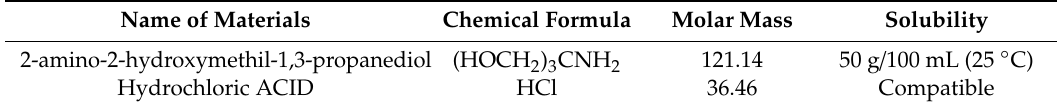
Table 2. Specifications of alkaline (Tris) bu ff er solution.